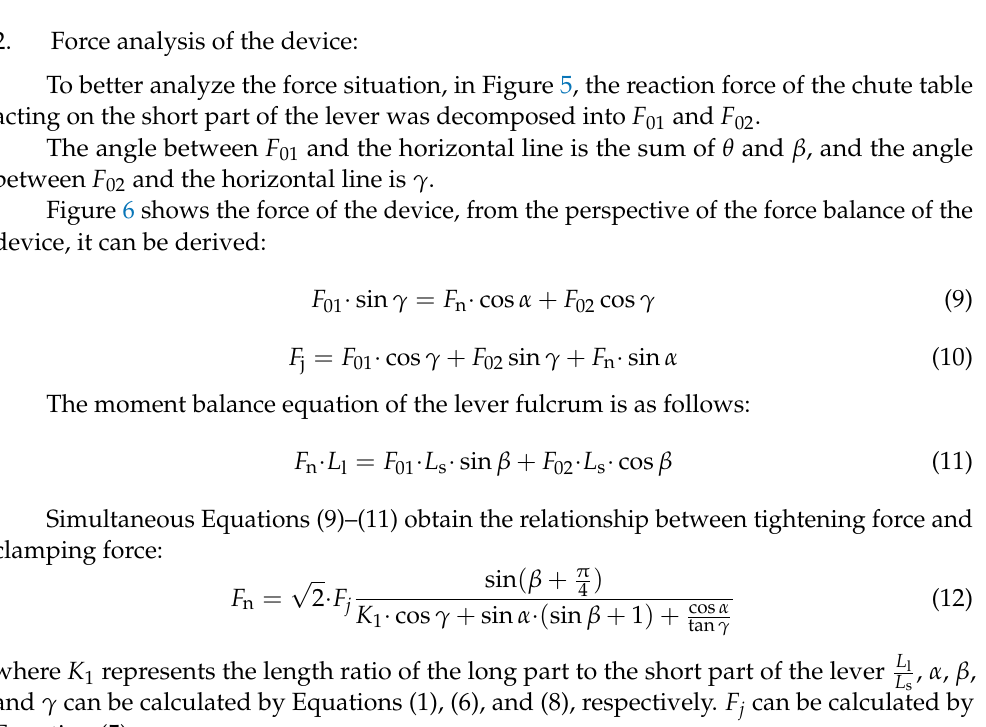
Figure 5. Force decomposition at the bottom of the lever.